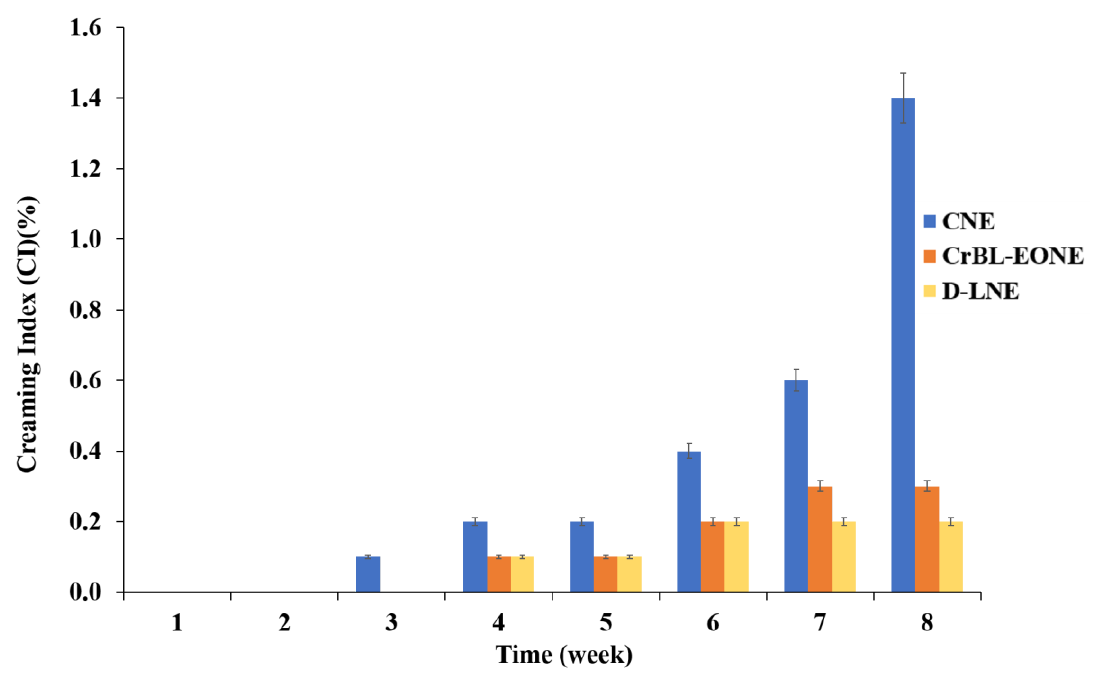
Figure 3. The creaming index (CI%) values of the control nanoemulsion treatment (CNE), C. reticulata leaf essential oil nanoemulsion (CrBL-EONE), and D-limonene nanoemulsion (D-LNE) after eight weeks of storage at 5 °C.